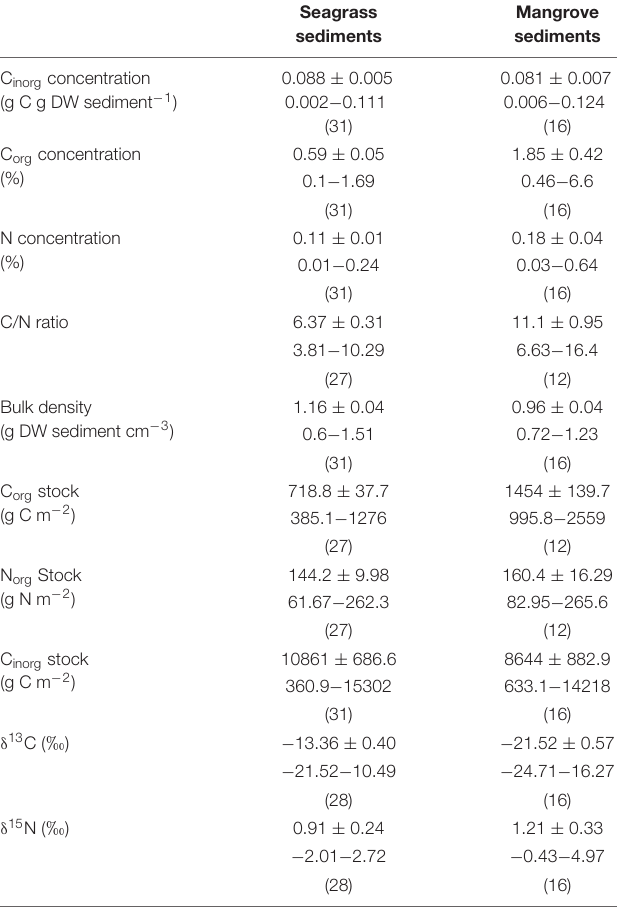
Stocks integrated over the 10 top cm of sediment. The range of values and the number of replicates in parenthesis are indicated.